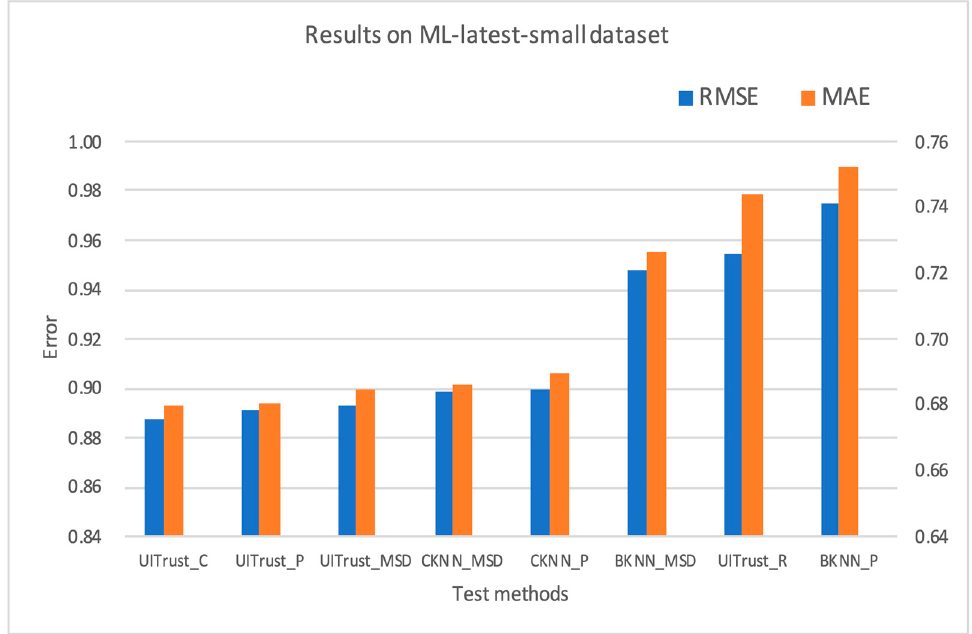
Figure 3. Prediction accuracy obtained using different methods for the ML-latest-small dataset. MAE—mean absolute error, RMSE—root mean square error.